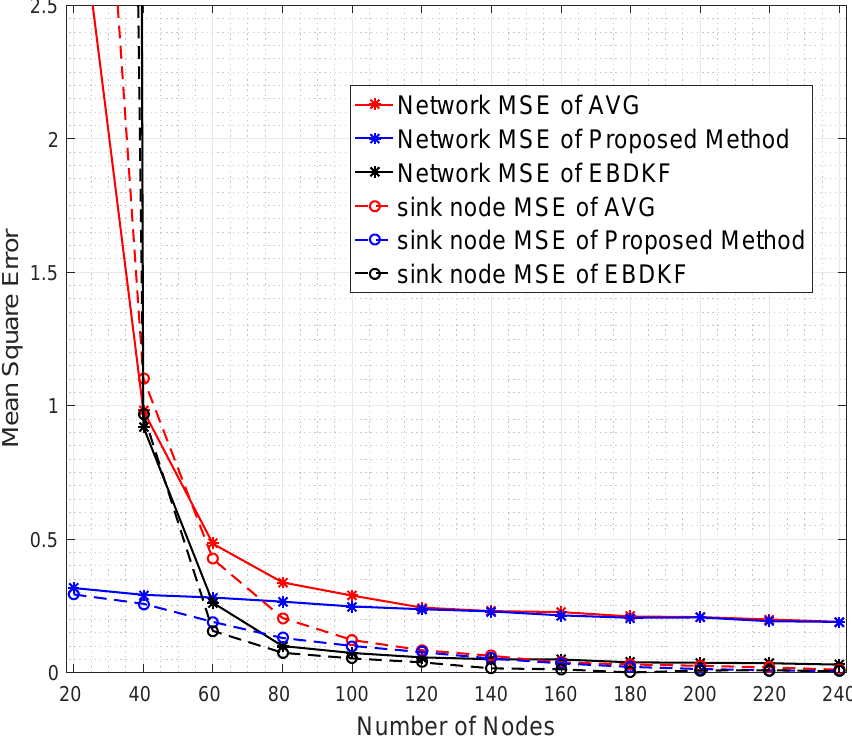
Figure 12. Accuracy comparison among the proposed statistical, AVG, and EBDKF information fusion methods in a tree-based IoT